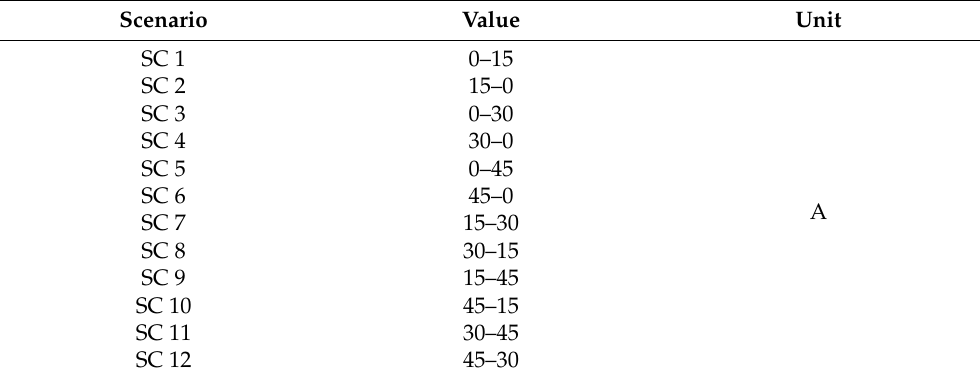
Table 2. Summary of the operating scenarios used to perform the experiments.